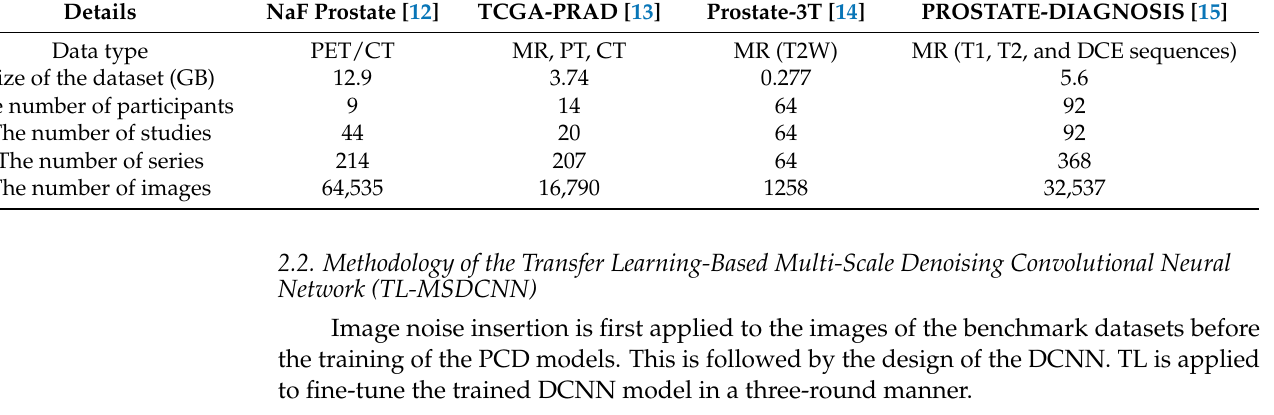
Table 1. Summary of the benchmark datasets.